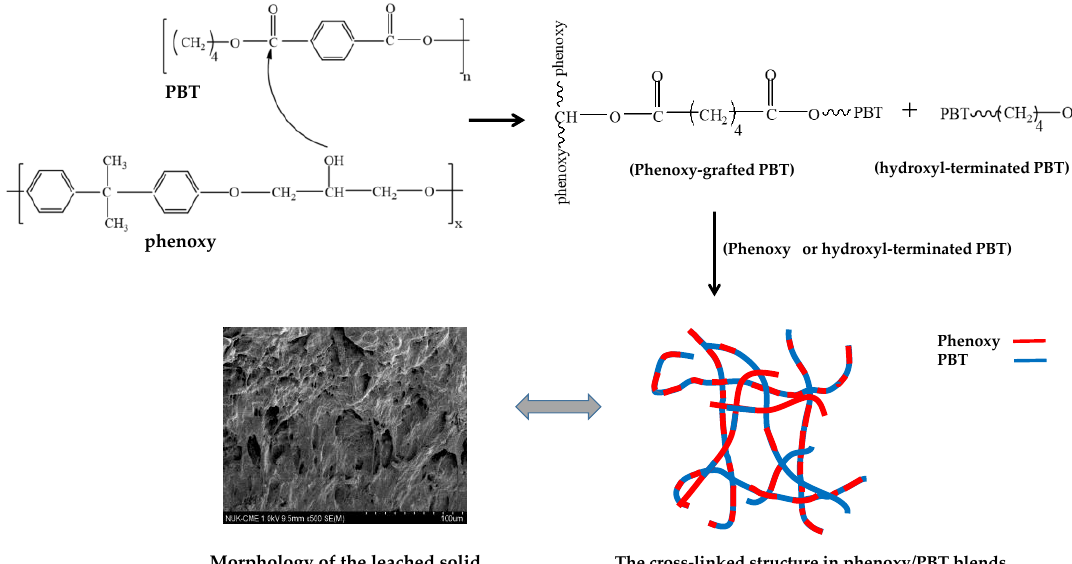
Figure 7. FTIR spectra of phenoxy/PBT (5/5) in the carbonyl absorption region for blends annealing at 260 °C for various periods of time. ( a) extracted solute and ( b ) eached solids. In each diagram, spectrum (I) 0, (II) 30, (III) 60, and (IV) 90 min,